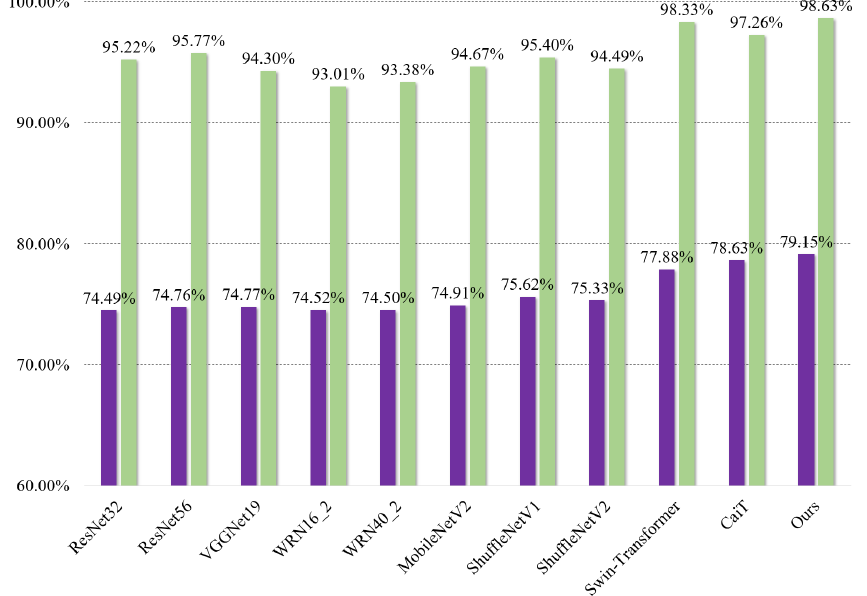
Figure 3. The prediction accuracy comparison of all algorithms. The purple blocks show the prediction accuracy on the multi-classification task of the Kvasir-Capsule dataset, and the light green blocks show the prediction accuracy on the binary classification task of the RLE dataset. Our method exhibits the best performance on both tasks.